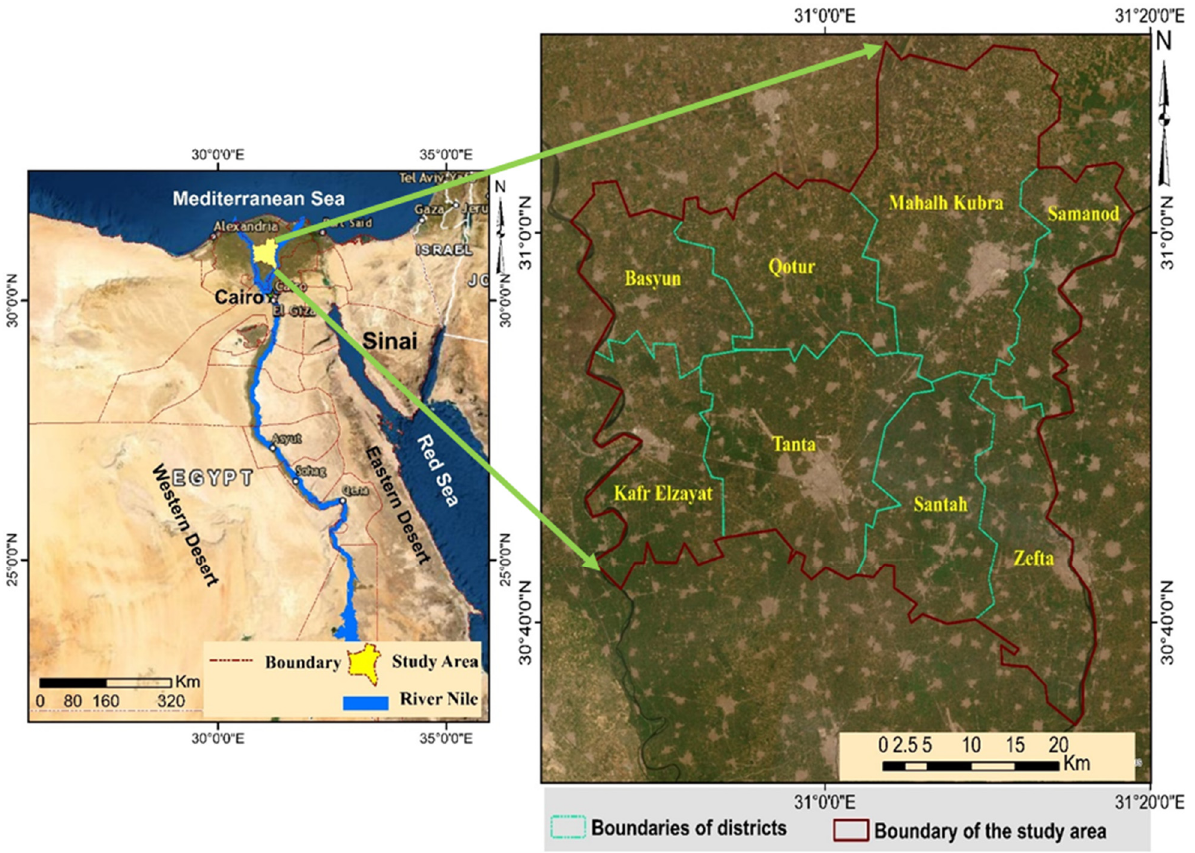
Figure 1. The study area of Gharbia governorate, Egypt [35].